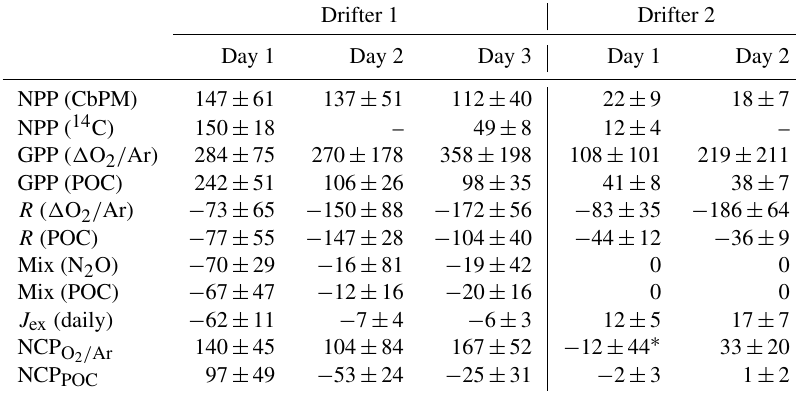
∗ Calculated using summed 3h increments of NCP O2 / Ar (refer to Table 2 and Sect. 2.6.3). All other NCP values reported here were computed using day and night linear regressions of [POC] and [ O 2 ] bio against time (Sect. 2.6.1, 2.6.2).